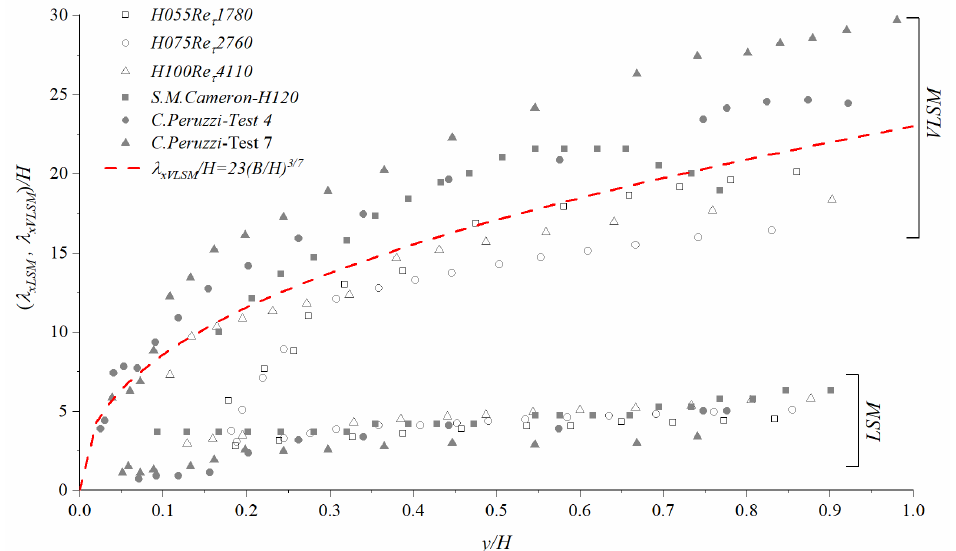
Figure 7. Wall-normal distributions of streamwise wavelengths corresponding to the peaks of LSMs and VLSMs.